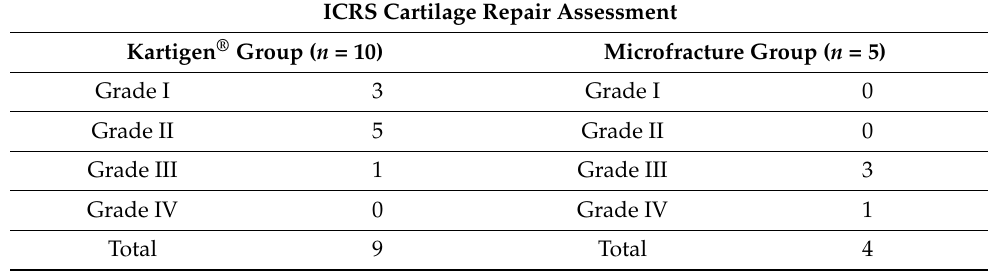
Figure 3. Arthroscopic images before and 1 year after operation. Images of Kartigen ® group ( A ) and microfracture group ( B ). Table 2. ICRS arthroscopic